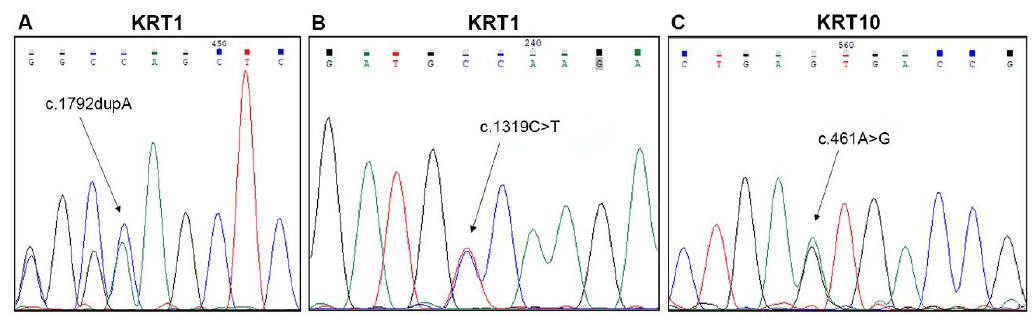
Figure 1. Molecular findings in three familial and two sporadic cases of epidermolytic ichthyosis. Sequence electropherograms showing the three novel mutations identified: ( A ) c.1792dupA (p.Ser598Lysfs*56), ( B ) c.1319C > T (p.Ala440Val) in KRT1 (NM_006121) (patients n . 1–3 and 4 of Table